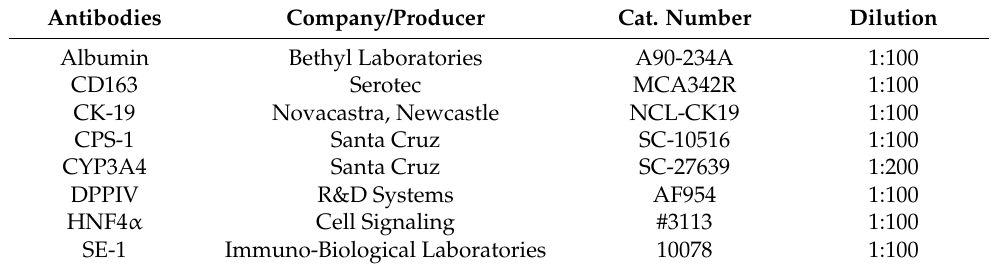
Table 1. Primary